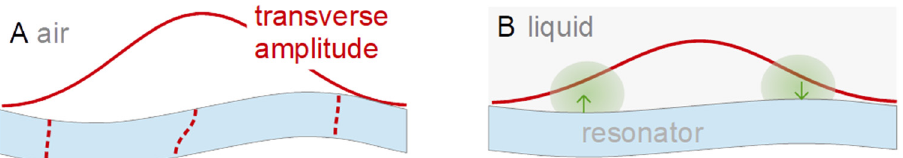
Figure 5. In liquids, the pressure exerted by the fluid reduces bending. There is extensional strain inside the crystal (causing bending) but the same extensional strain is present in the adjacent liquid as well. For volume conservation, extensional strain along x inside the liquid causes a corresponding strain along z, which exerts a normal stress onto the plate and thereby reduces bending.